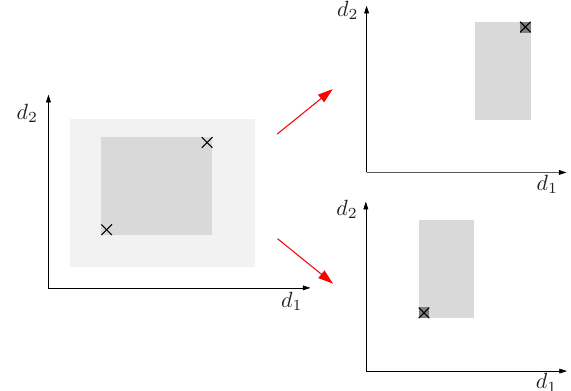
Figure 2. Searching for two solutions (indicated by crosses) in a two-dimensional distance space using a branch-and-prune approach. The initial search space (light gray rectangle on the left plot) is reduced as much as possible, but without leaving out any solution. The result is the middle-gray rectangle. Then this space is bisected and the search is repeated independently in the two resulting sub-spaces, as shown in the right part of the figure. Finally, the solutions are isolated as small boxes in distance space (the dark-gray squares around the